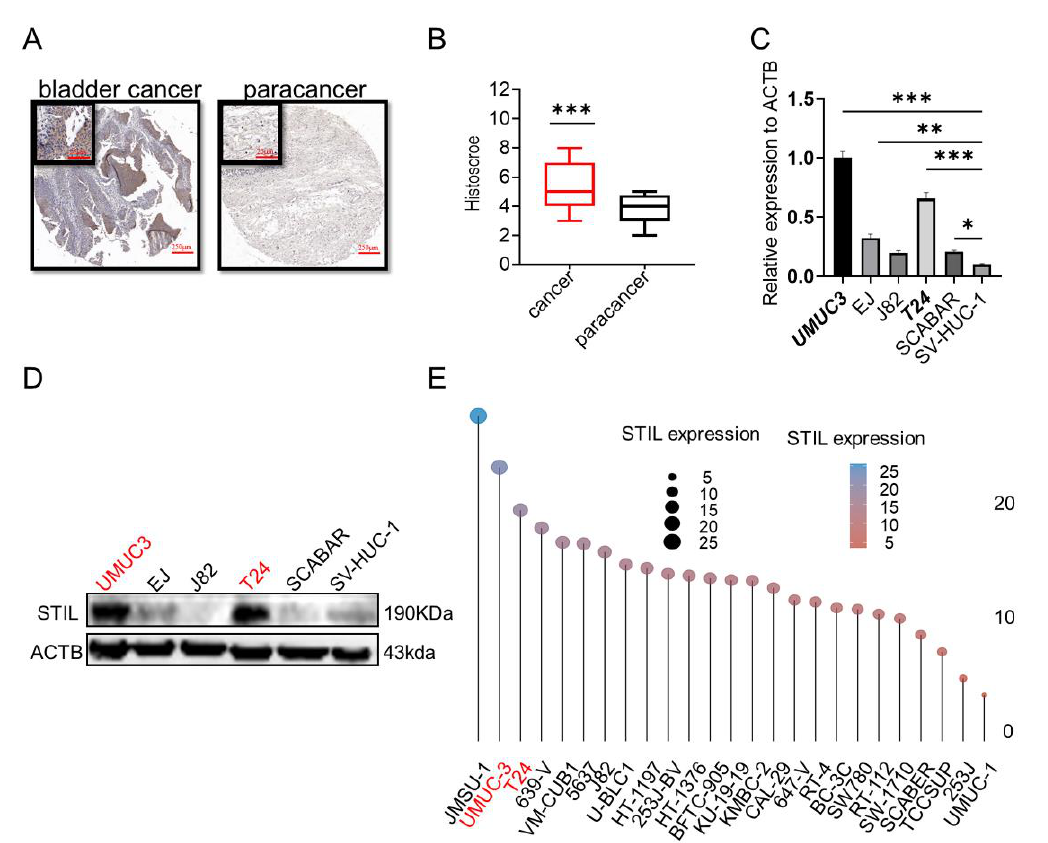
Figure 2. The expression of STIL in BC was higher than in the normal bladder. ( A , B ) Tissue microarray analysis of STIL expression in 16 paracancer tissues and 63 BC tissues. ( A ) Representative images of BC and paracancer tissues. ( B ) Histoscore of BC and paracancer tissues. ( C ) The mRNA levels of STIL in five BC cell lines (UMUC3, EJ, J82, T24, SCABAR) and the normal bladder cell line (SV-HUC-1). ( D ) Protein levels of STIL in the UMUC3, EJ, J82, T24, SCABAR, and SV-HUC-1 cells. ( E ) Expression distribution of STIL in different cell lines. The horizontal coordinate, dot size, and different colors represented levels of expression. The BC cell lines mRNA expression matrix was collected from CCLE (https://portals.broadinstitute.org/ccle, Accessed on 2 August 2022). This result was obtained by R (v4.0.3) package ggplot2 (v3.3.3) (ACTB, β -actin) (* p < 0.05, ** p < 0.01, and *** p < 0.001).